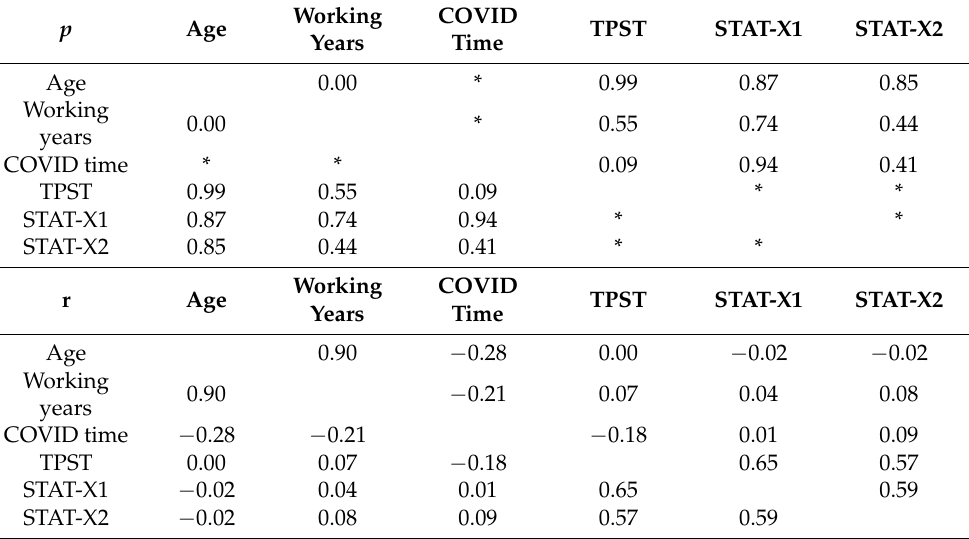
Table 3. Spearman correlation (p values and the correlation coefficient) of the data from the study’s responders. TPST—Post-Traumatic Stress Test, STAI-X1—State-Trait Anxiety Inventory—state, STAI- X2—State-Trait Anxiety Inventory—trait. *—statistically